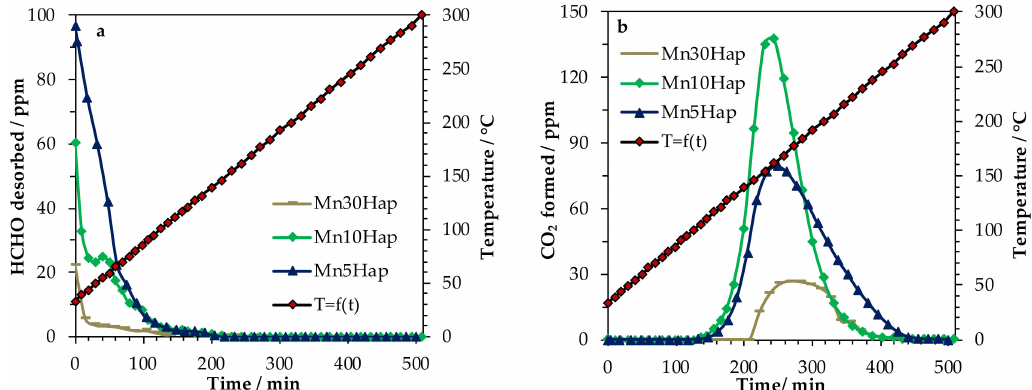
Figure 8. ( a ) Amount of desorbed HCHO and ( b ) CO 2 production as a function of temperature for MnxHap